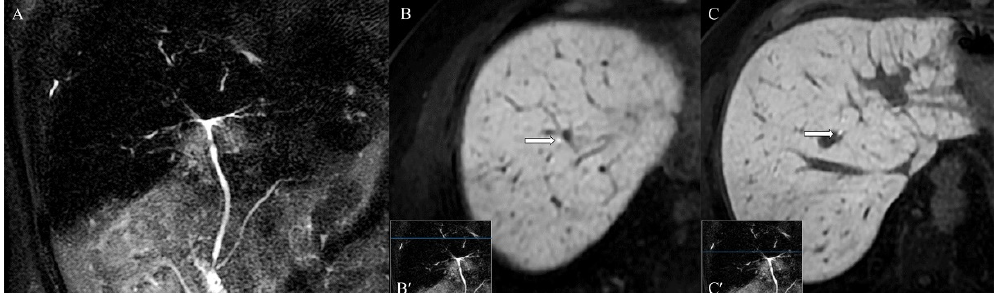
Figure 5. ( A ) MRI cholangiography phase, in the absence of anamnesis, does not allow a confident differential diagnosis with primary sclerosing cholangitis. ( B , C ) After administration of Gd-EOB-DTPA, hepatobiliary phase images ( B ) above and ( C ) below the stenosis demonstrate physiological opacification of the intrahepatic bile ducts and, despite the stenosis, physiological contrast flow.